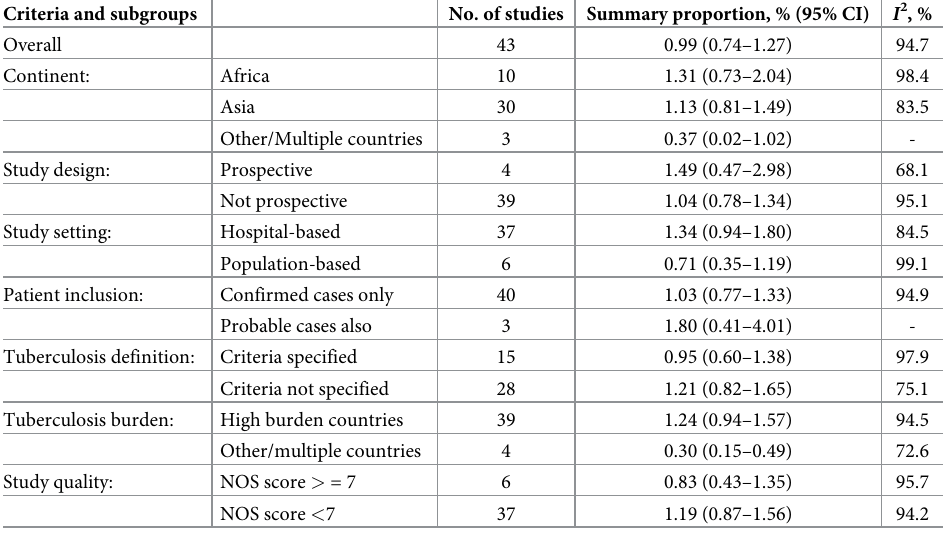
Table 2. Subgroup analysis for summary estimates for proportion of COVID-19 patients with active pulmonary tuberculosis. Criteria and